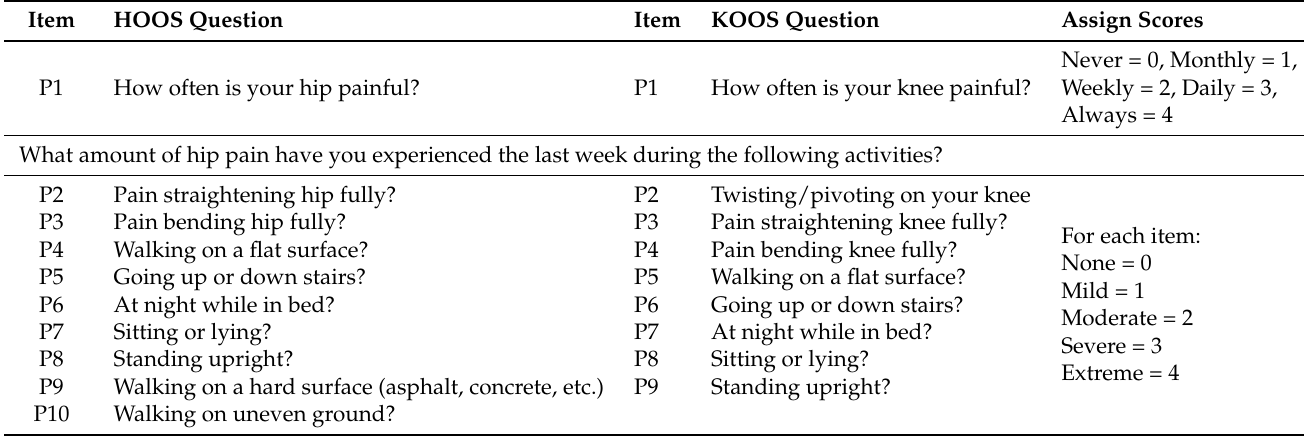
Figure 6. ( A ) Kellgren–Lawrence grading scale and ( B ) statistical distributions of Kellgren–Lawrence scores of HOA and KOA patients. Table 2. The HOOS and KOOS subscales pain items.